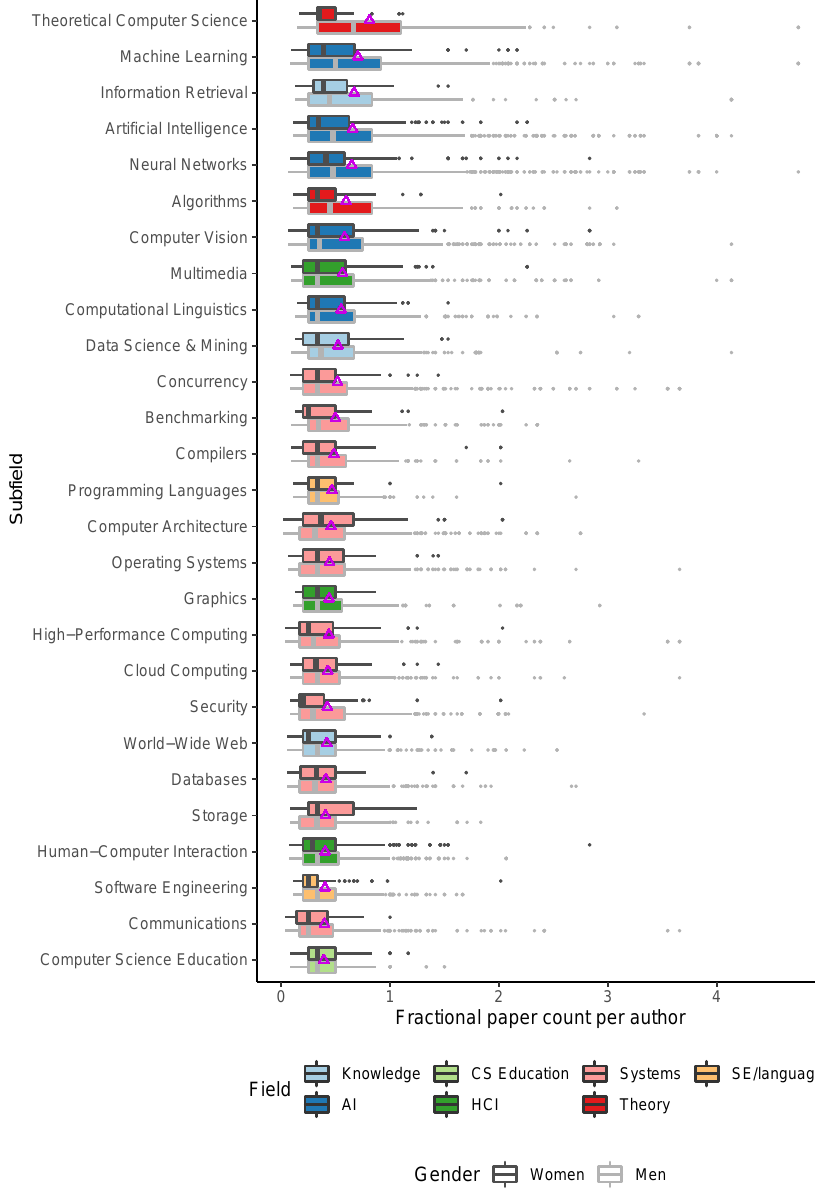
Figure 4. Distribution of fractional paper counts per author by gender, field, and subfield. Each box- plot shows the interquartile range (25–75th percentiles) in the filled box area, eith vertical notches denoting medians. The horizontal lines represent the 5–25th percentile range on the left and the 75–95th percentile range to the right. Dots further to the right denote outlier points above the 95th percentile. The top boxplot for each subfield shows the distribution for women, followed by the distribution for women. Triangles represent median values for both genders, which is used for sorting